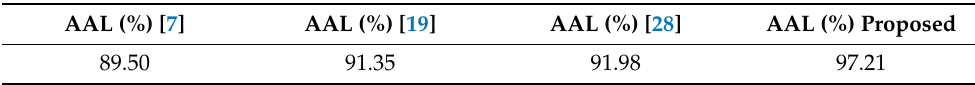
Table 5. Average accuracy for life expectancy